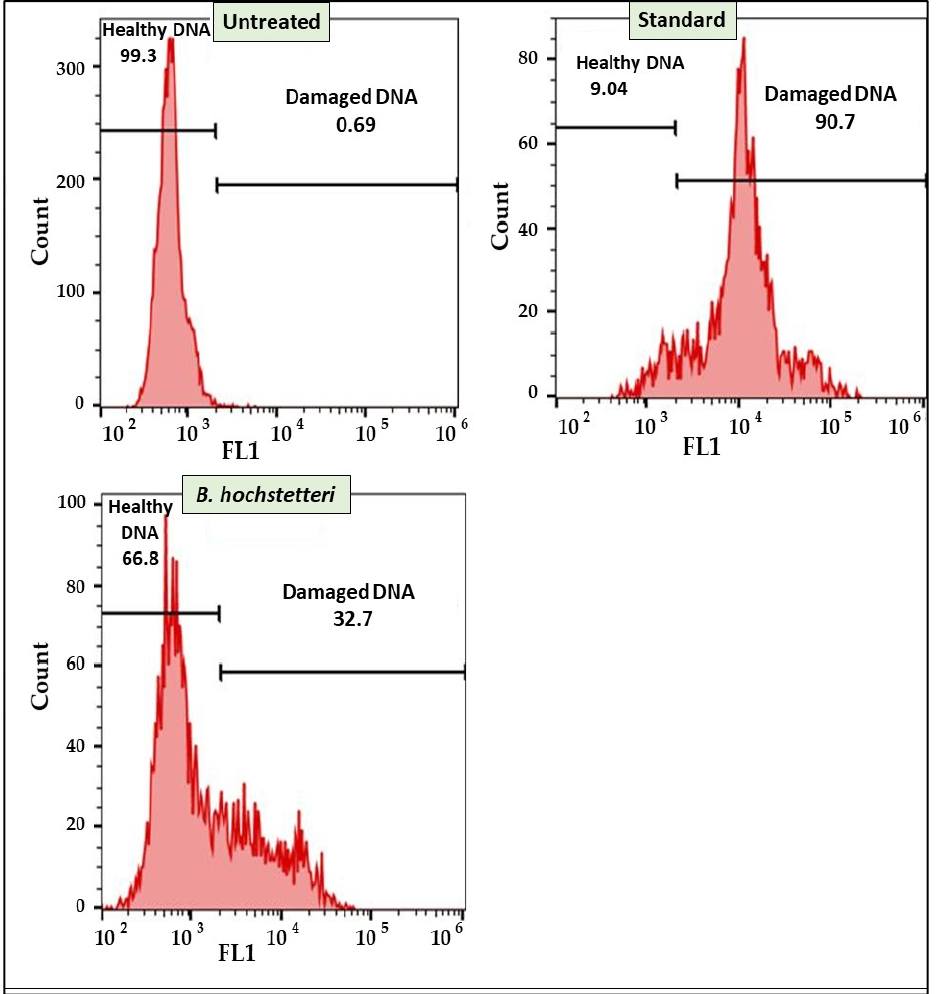
Figure 4. Effect of methanol extract of B. hochstetteri on DNA damage in the lung cancer A549 cell line.